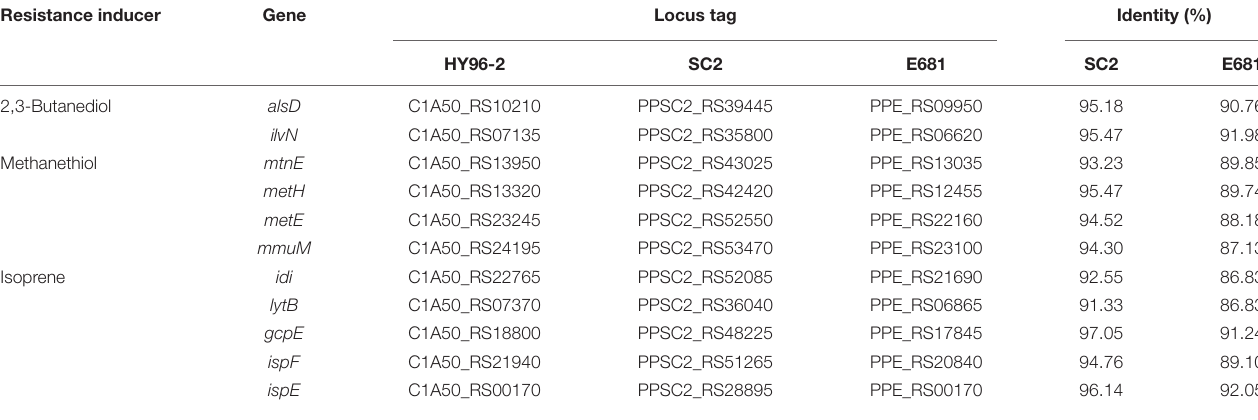
TABLE 5 | Comparison of genes involved in the synthesis of resistance inducers in strain HY96-2, as well as in strains SC2 and E681. Resistance